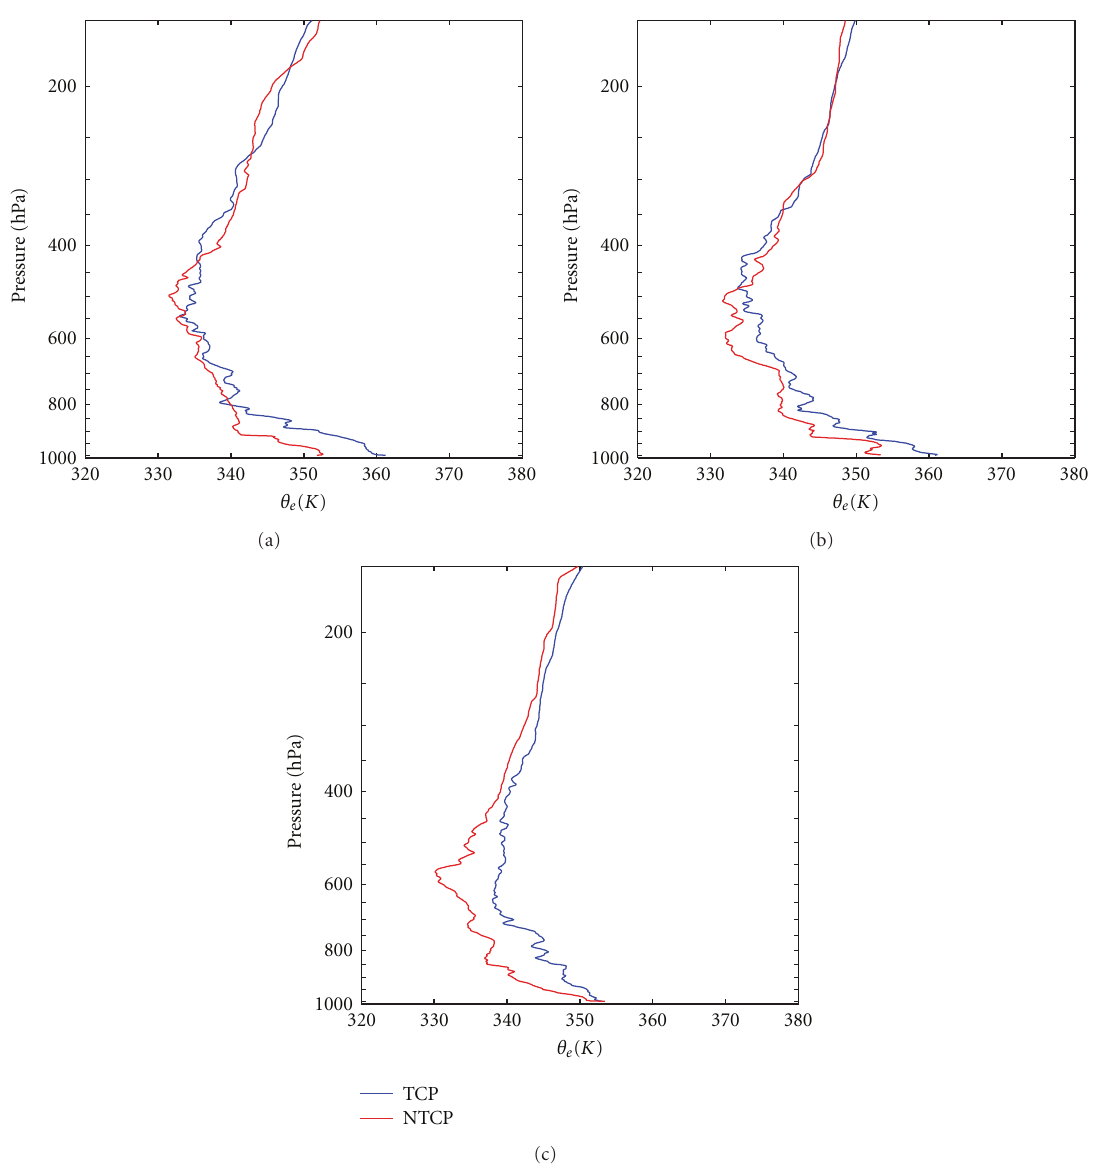
Figure 7: Same as Figure 4 except for θ e